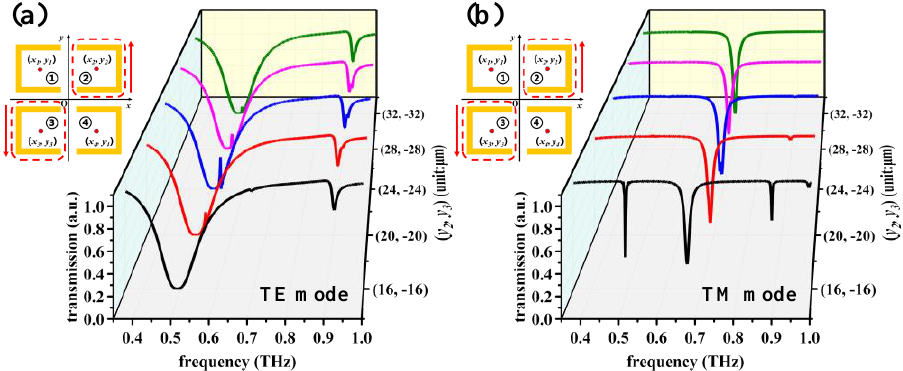
Figure 9. Simulated transmission spectra of RTM device obtained by moving the SRR-2 and SRR-3 meta-atoms along positive and negative y -axis directions in ( a ) TE and ( b ) TM modes, respectively.